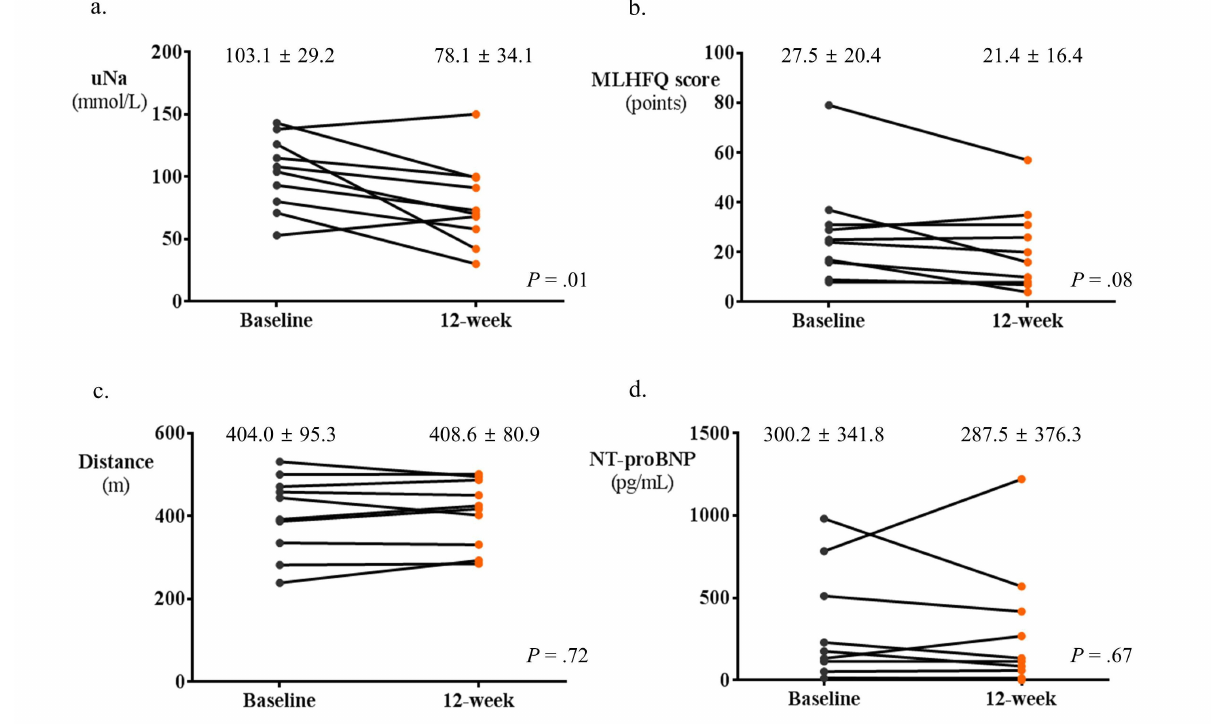
Figure 5. Changes in major outcomes over time by information communication technology (ICT)–based telehealth program in patients with good adherence. In patients with good adherence, uNa significantly decreased after 12 weeks of intervention (a), whereas MLHFQ scores marginally decreased (b). There were no changes in 6-minute walk distance (c) and NT-proBNP level (d). NT-proBNP: N-terminal prohormone of brain natriuretic peptide, MLHFQ: Minnesota Living with Heart Failure Questionnaire.